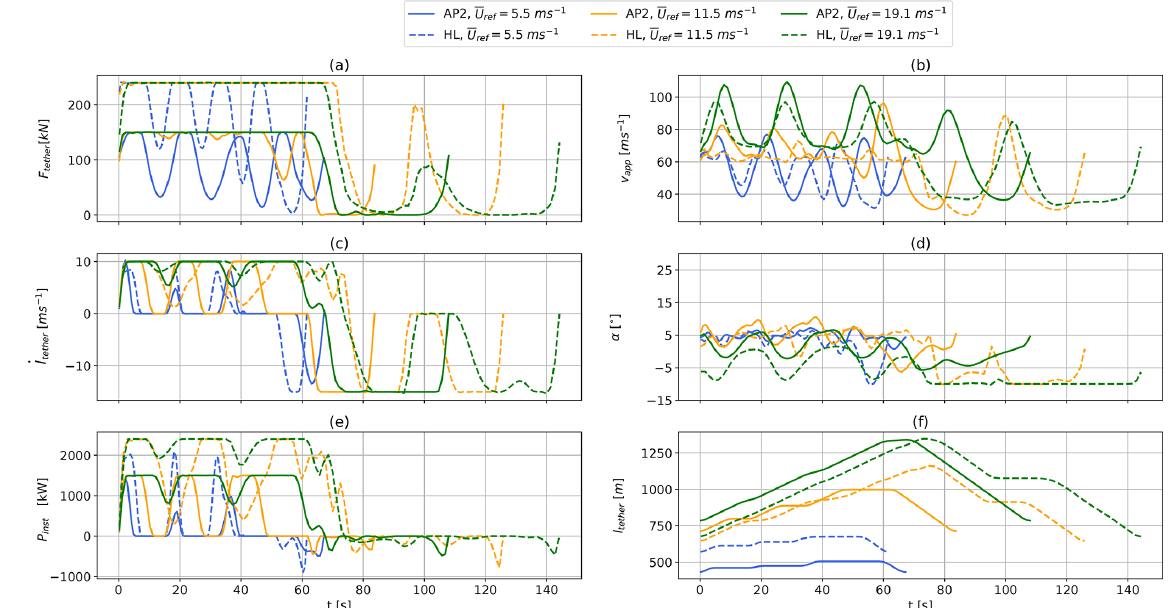
Figure 6. Time series of one optimized pumping cycle for the ground-generation AWES with a wing area of A = 50m 2 , mass-scaling exponent κ = 3 for both AP2 reference (solid lines) and high-lift HL (dashed lines) aerodynamic coefficients at various WRF-generated wind conditions. The corresponding trajectories are shown in Fig. 5. The diagrams show tether force F tether (a) , apparent wind speed v app (b) , tether-reeling speed v tether (c) , angle of attack α (d) , instantaneous power P inst (e) and tether length l (f)